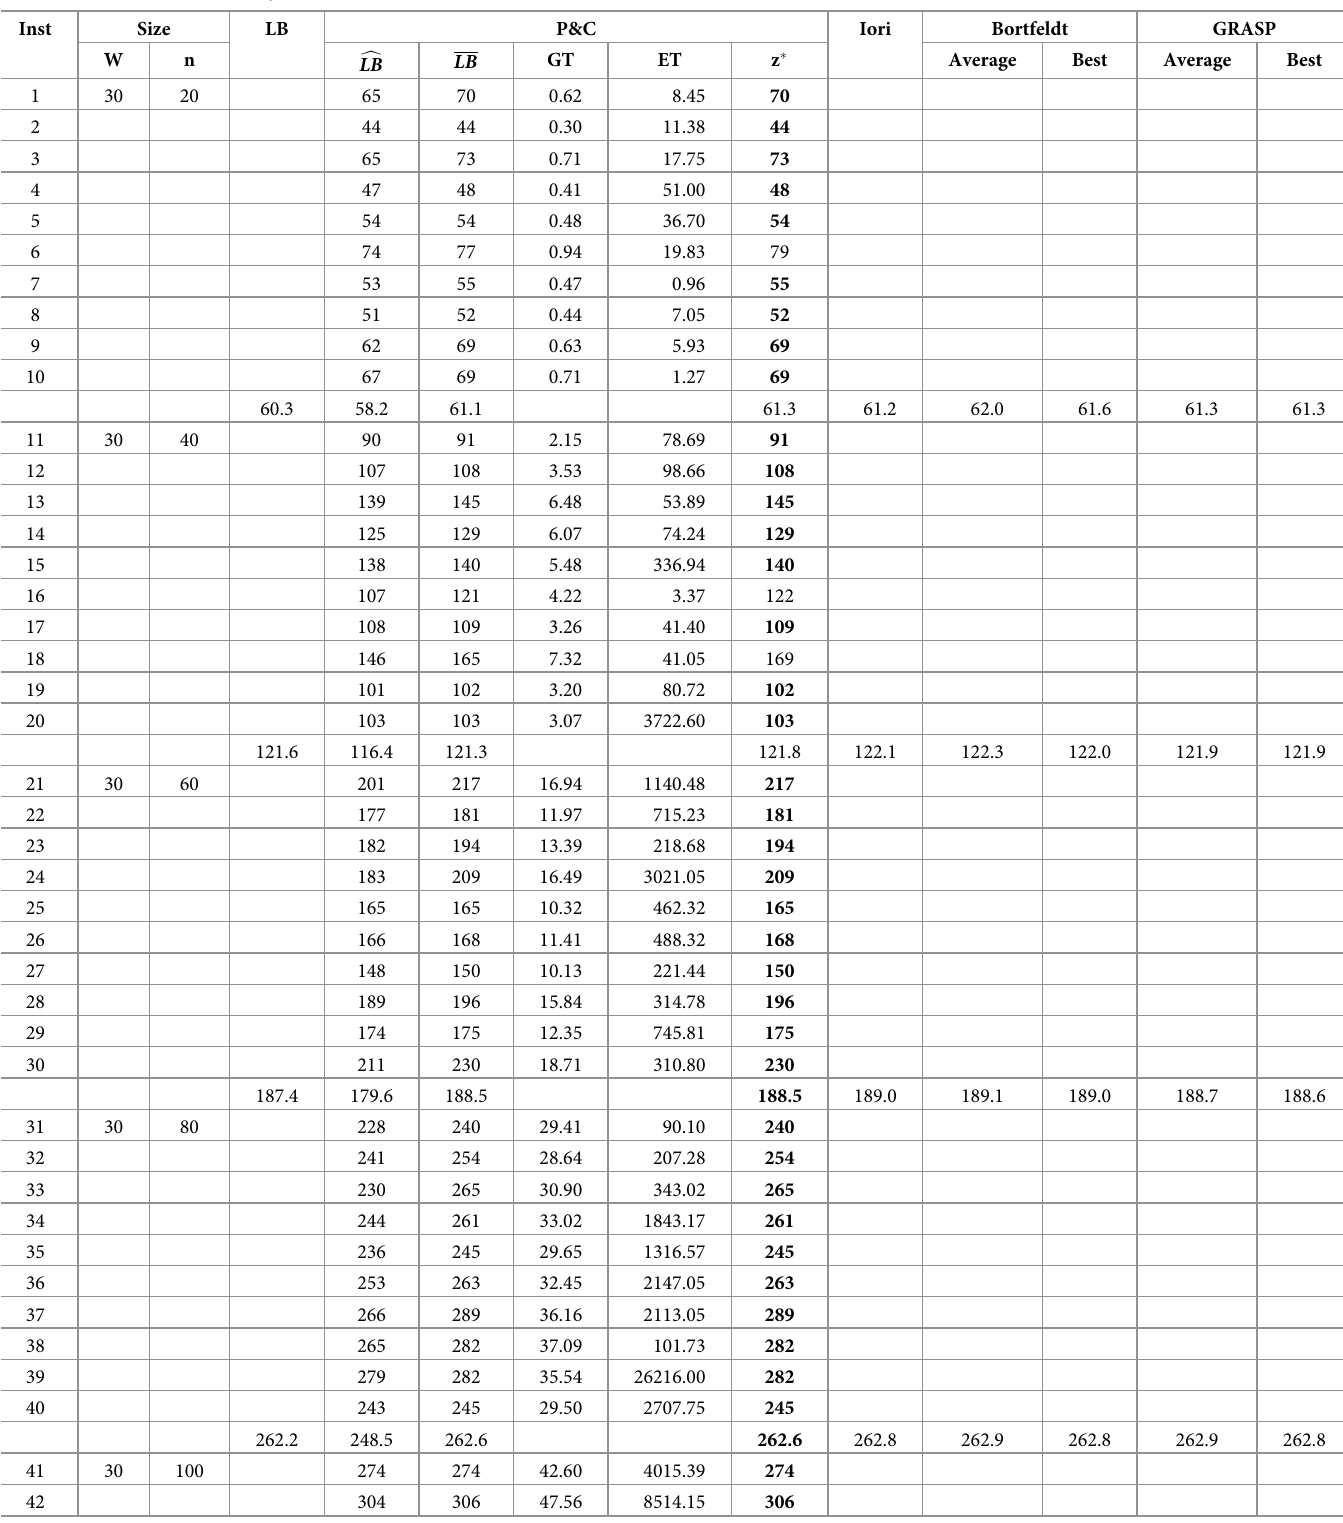
Table 8. Results for BW instances, class